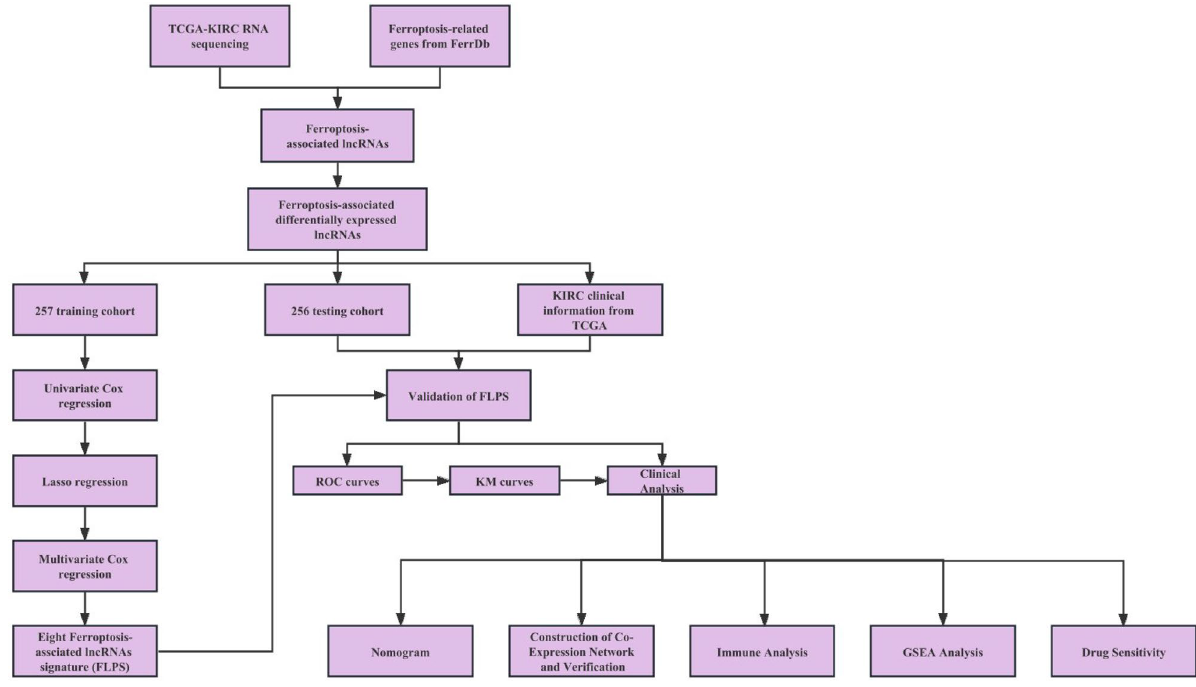
Figure 1. Flowchart of the